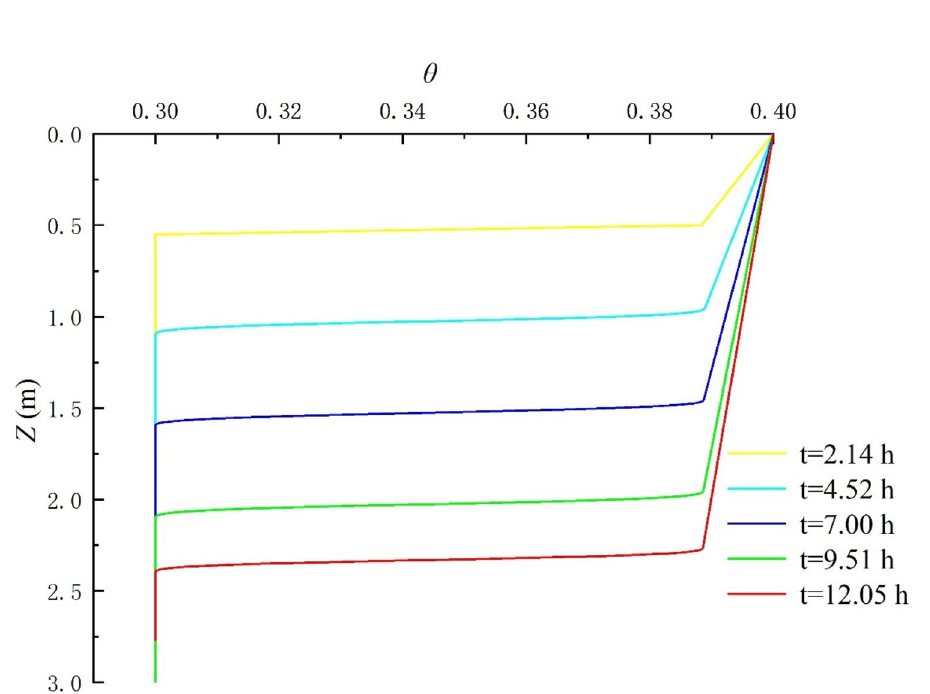
Figure 7. Schematic diagram of the variation of soil profile moisture content with